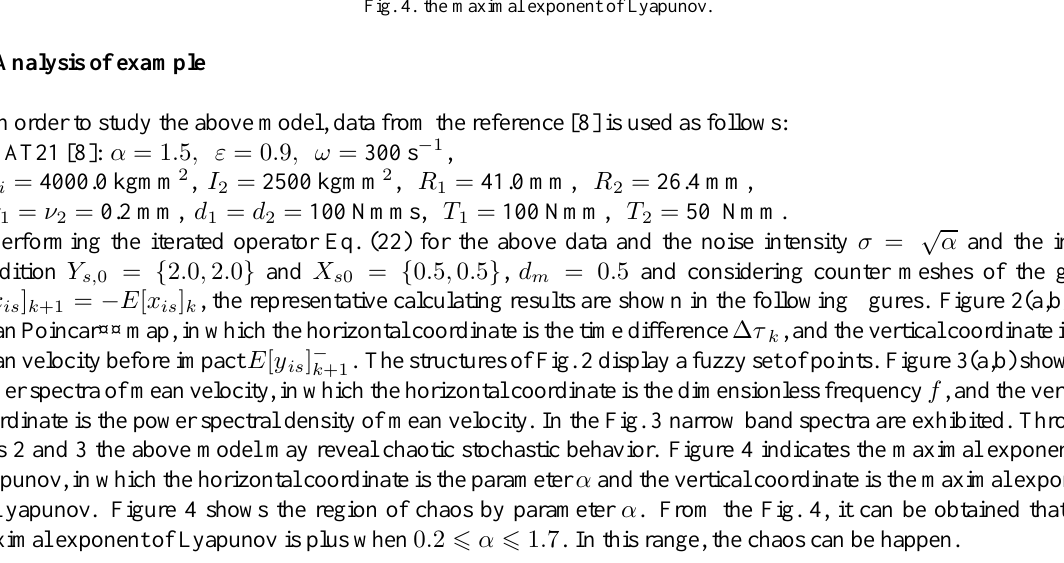
Fig. 4. the maximal exponent of